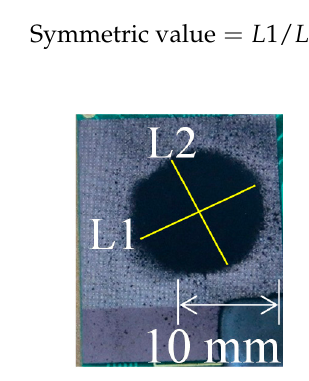
Figure 2. Symmetric value measurement of the deposited particle pattern where L 1: longest axis and L 2: shortest axis.